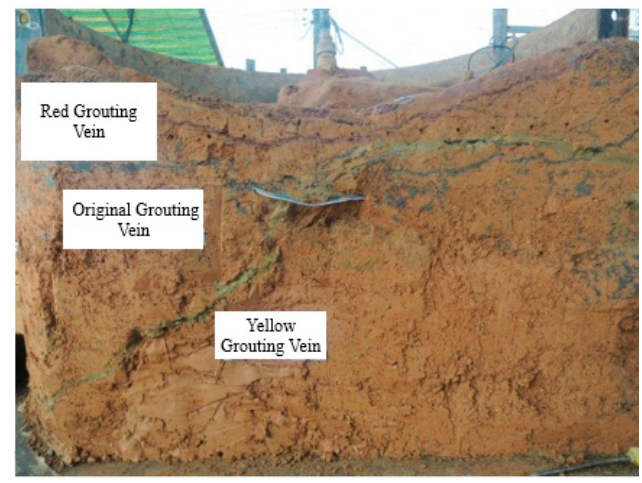
Figure 5. The veins of the whole excavation section.